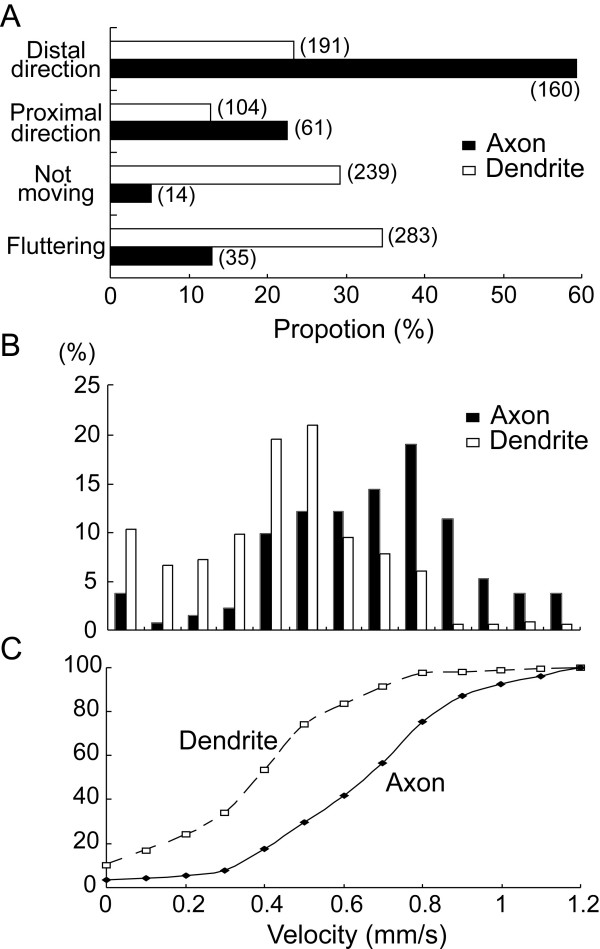
Properties of movement of BDNF-GFP puncta in axons and dendrites. A, A proportion of puncta which move in axons (filled columns) or dendrites (open columns) in the distal and proximal directions, do not move, and flutter within a small distance (10 μm). The numbers of puncta observed are given in parentheses. B, Distribution of moving puncta with different velocities. The bin width of the abscissa was 0.1 μm/s, and 0 indicates that the velocity was slower than 0.1 μm/s. The total numbers of vesicles analyzed were 132 in axons and 349 in dendrites. C, Cumulative plots of velocity distributions shown in the histograms of B. Dotted and continuous lines represent dendrites and axons, respectively.